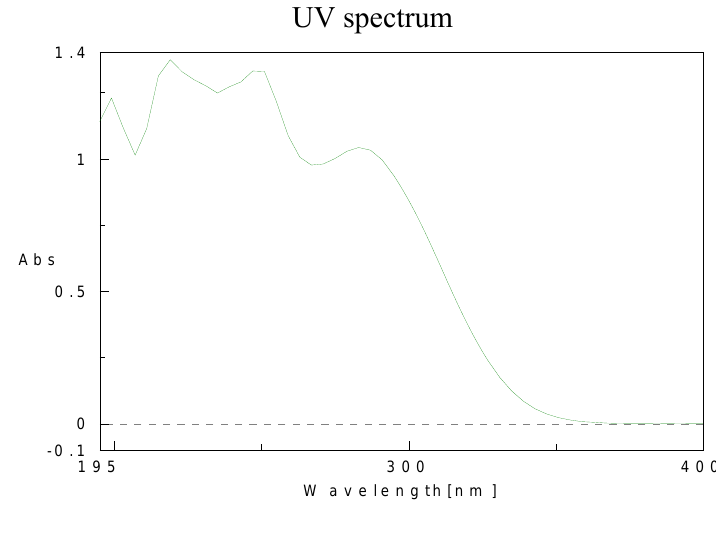
( Z )-Methyl 3-(4-(phenylthio)phenyl)but-2-enoate [( Z )-1d] Yellow oil. R ( n -hexane/ethyl-acetate 94:6); 1 H-NMR (CDCl )  ppm): 2.19 (d, 3H, J = 1.4 Hz), 3.60 (s, 3H), 3 5.94 (q, 1H, J = 1.4 Hz), 7.17 (d, 2H, J = 8.4 Hz ), 7.26-7.38 (m, 5H), 7.40-7.44 (m, 2H); HPLC-UV/PAD analysis: RT 7.0 min. UV spectrum 1 .4